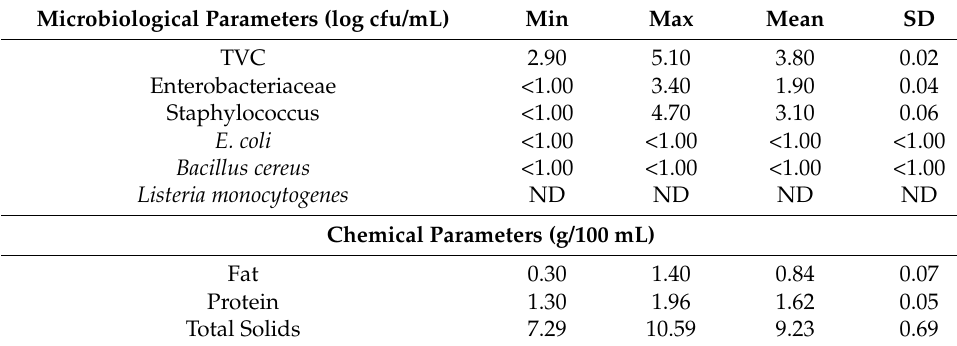
Table 3. Microbiological and chemical quality of raw donkey milk (n =